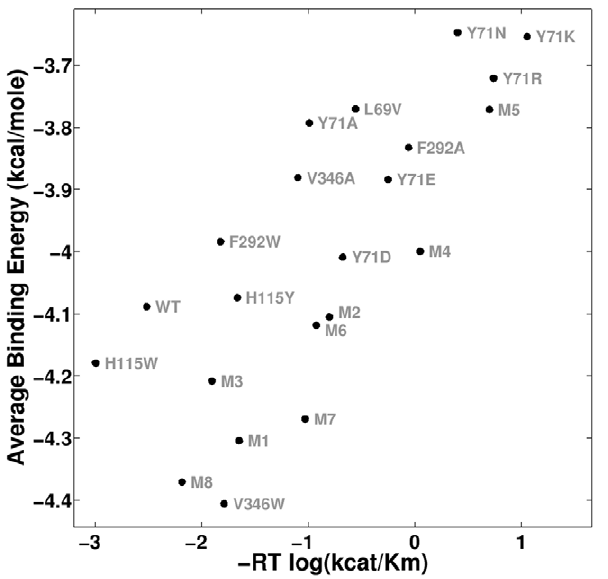
Figure 4. Predicted binding conformation of WT HuPON1 and VX ts ( + ) according to the D269-based hydrolysis mechanism. The specific binding method utilized the ITASSER/SMD structure of HuPON1 with d s =1.25 A˚ and d t =2.00 A˚. The structure has been energy minimized in Jaguar [31] using the OPLS energy function [32] with distance constraints on the breaking P-S bond and the nascent O-P bond. A full water molecule was utilized as the nucleophilic group for proper charge modeling.